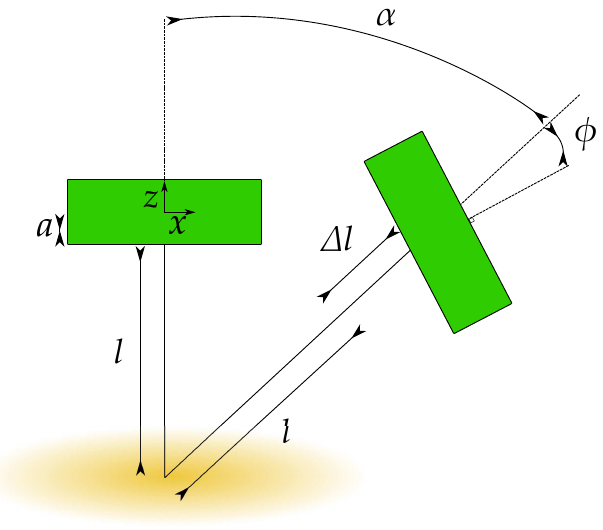
Fig. 5. A diagram depicting the variables of two coordinate systems.